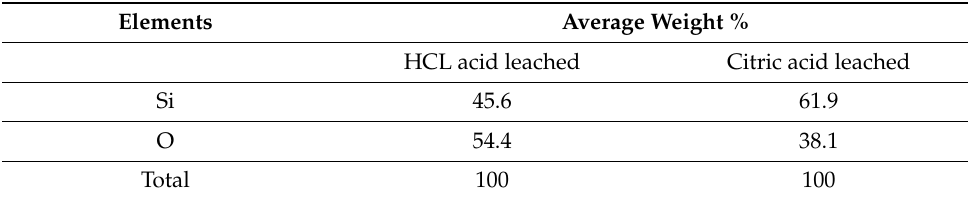
Table 4. EDS results of the synthesized silica Nanoparticles by acid treatment [36].